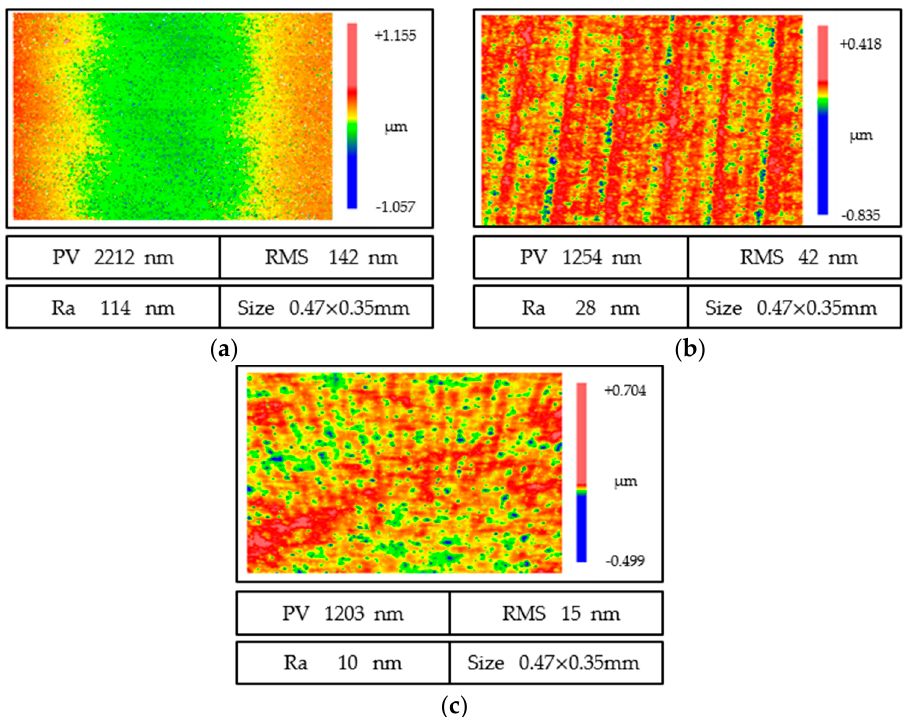
Figure 25. Evolution of surface quality. ( a ) Surface quality after grinding. ( b ) Rough surface quality. ( c ) Surface quality after finishing.